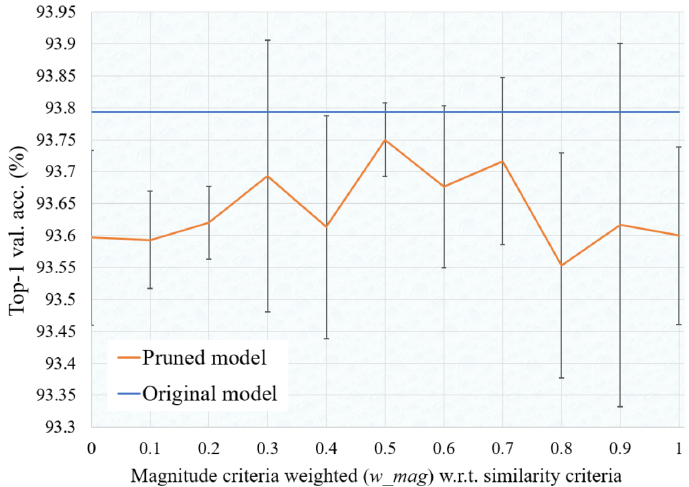
Figure 1. VGGNet validation accuracy across various values of w mag on the CIFAR-10